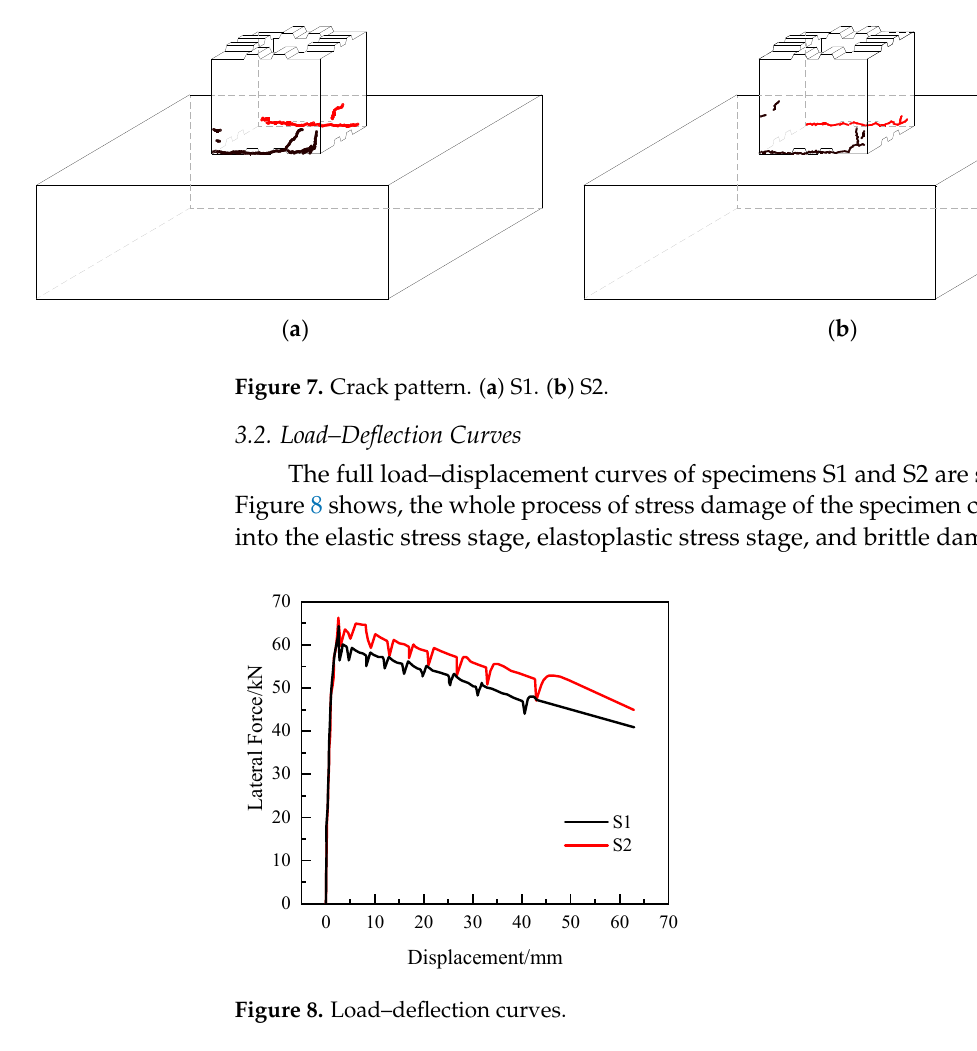
Figure 6. Failure mode of S1 and S2. ( a ) Pier bottom cracks of S1. ( b ) Oblique cracks of S1. ( c ) Pier bottom buckling of S1. ( d ) Pier bottom cracks of S2. ( e ) Penetration cracks of S2. ( f ) Pier bottom crushed of S2.